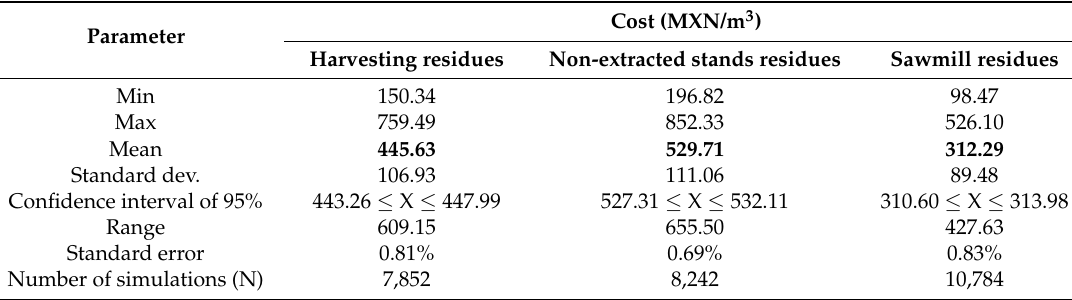
Table 6. Monte Carlo simulation results according to cost for the northern region.